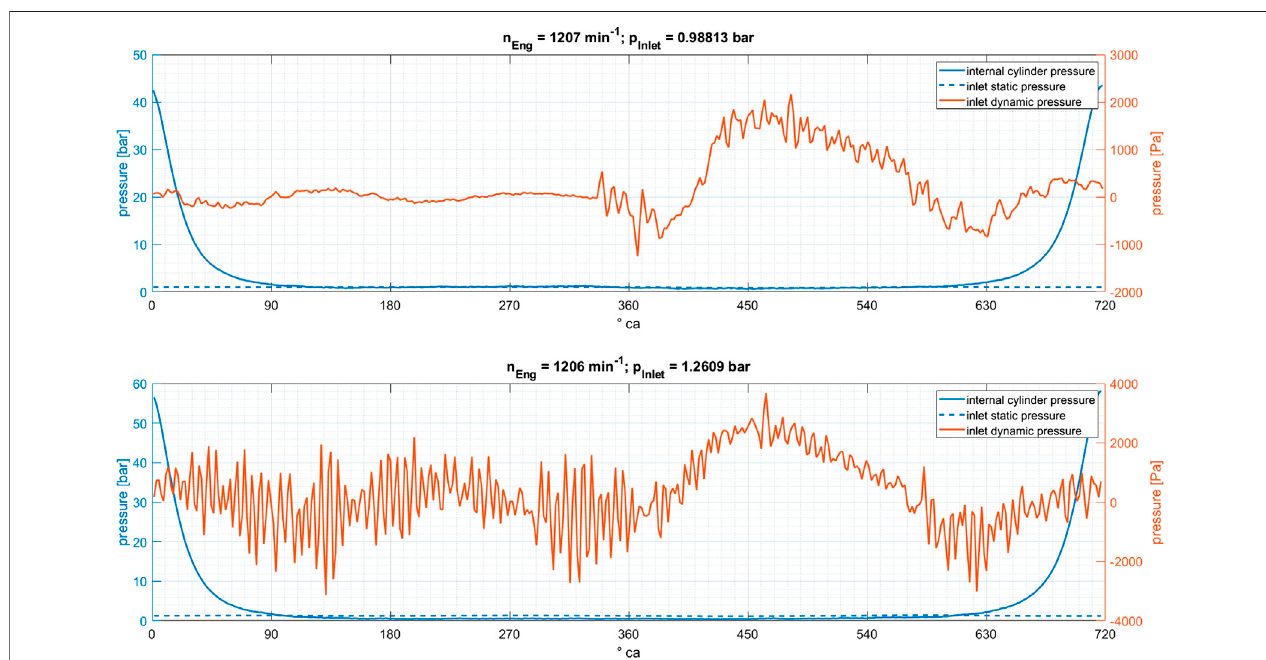
FIGURE 9 | The static and dynamic pressure in the inlet duct along with the in-cylinder pressure at the engine speed of 1,200 rpm. Top graph: naturally aspirated mode; Bottom graph: boosted conditions.